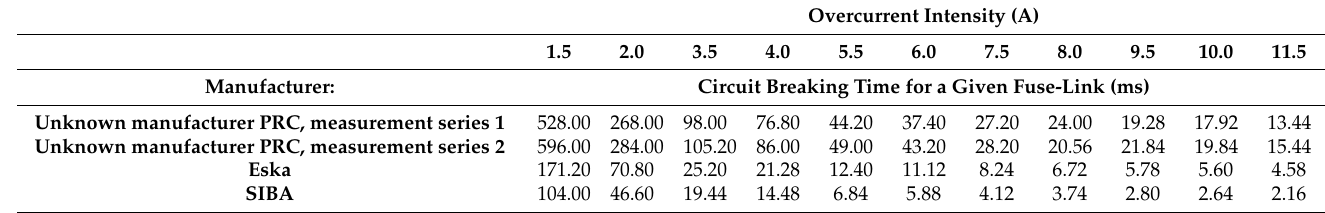
Table 2. Results of destructive testing involving glass tube miniature fuse-links, without a quenching medium and with a rated current of 0.5 (A), for the selected overcurrent intensities in the range of (1.5 ÷ 11.5)